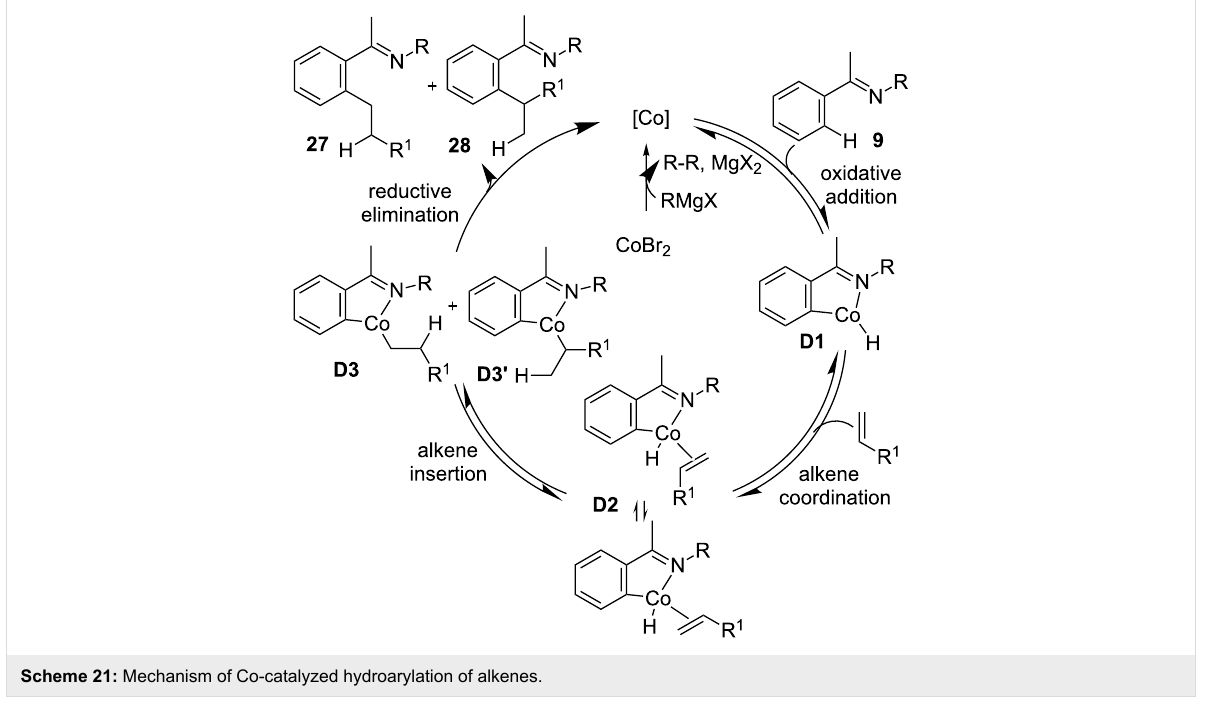
Scheme 21: Mechanism of Co-catalyzed hydroarylation of alkenes.